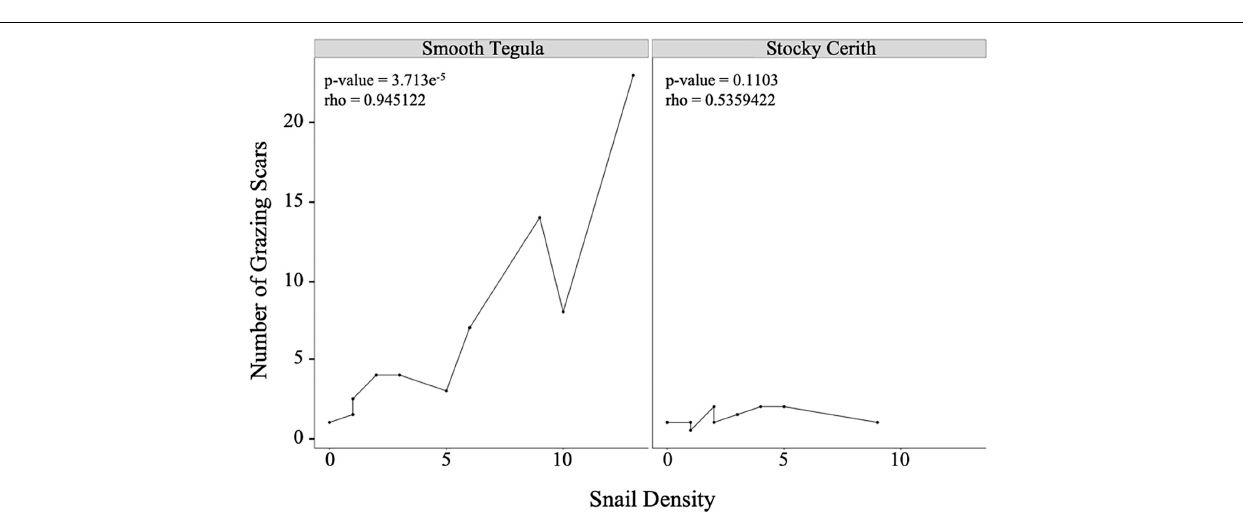
FIGURE 4 | Left: The correlation between number of grazing wounds per turtlegrass blade and smooth tegula ( Tegula fasciata ) snail density. Right: The correlation between the number of grazing wounds and stocky cerith ( Cerithium litteratum ) snail density. P -values and adjusted R 2 values are reported for the linear